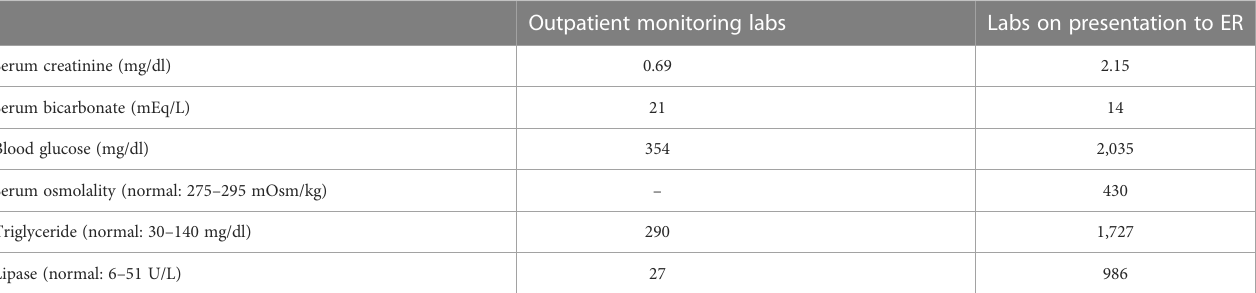
TABLE 1 Overview of pertinent laboratory data comparing routine labs obtained at a hematology/oncology clinic visit 5 – 7 days prior to hospital admission to labs obtained in the emergency department on presentation. Outpatient monitoring